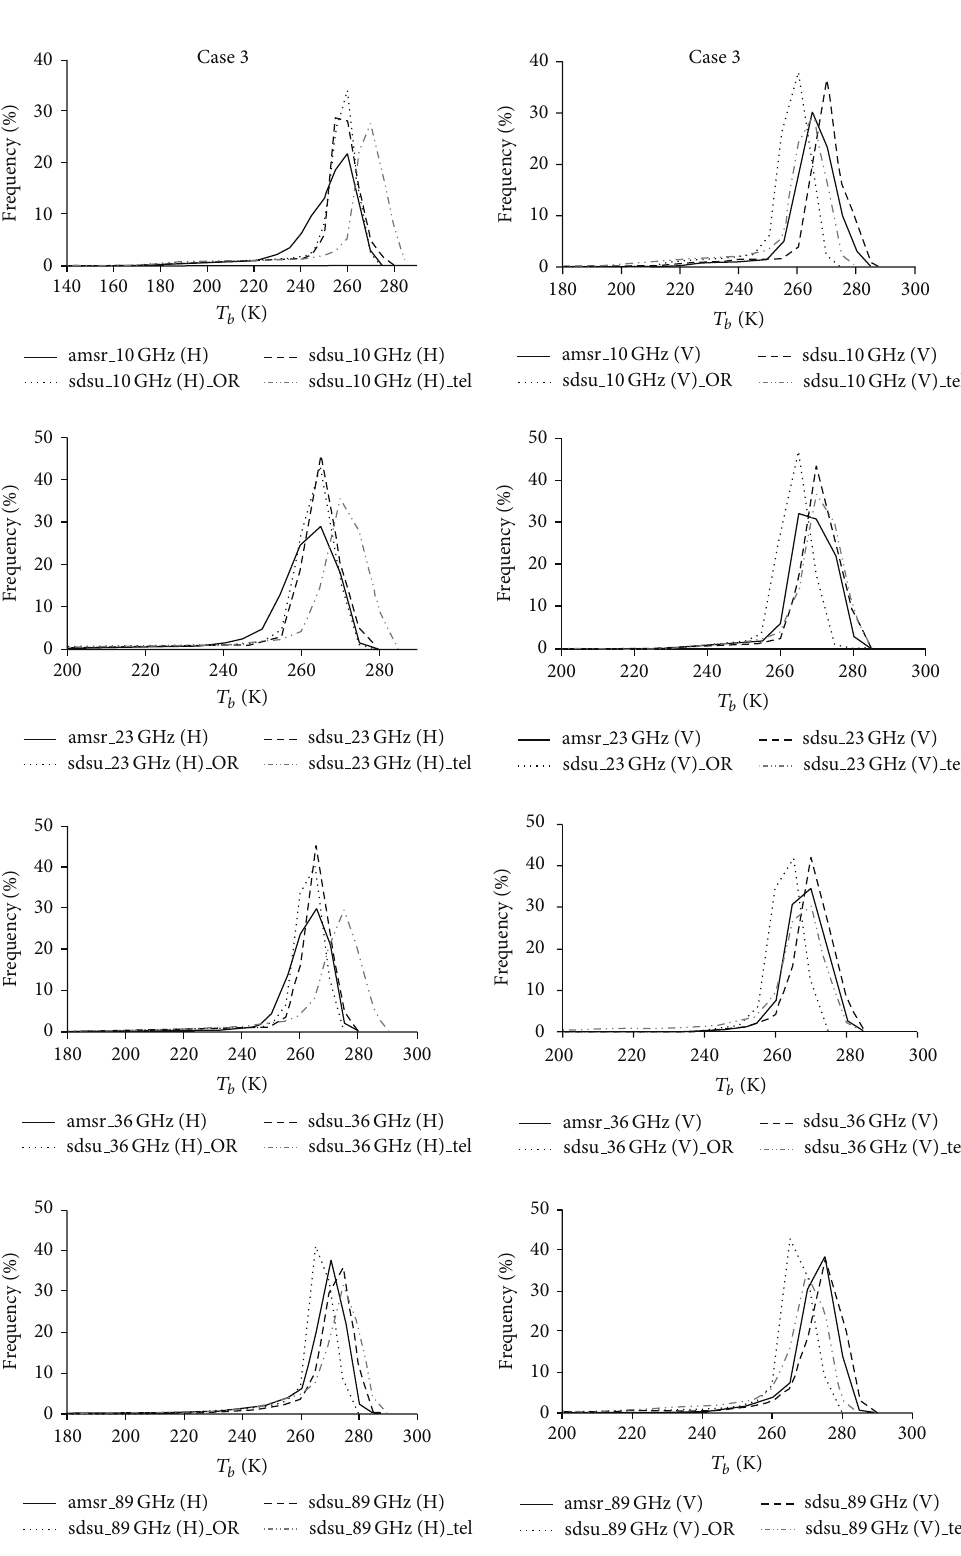
Figure 9: The same as in Figure 5, for the case of 15 March